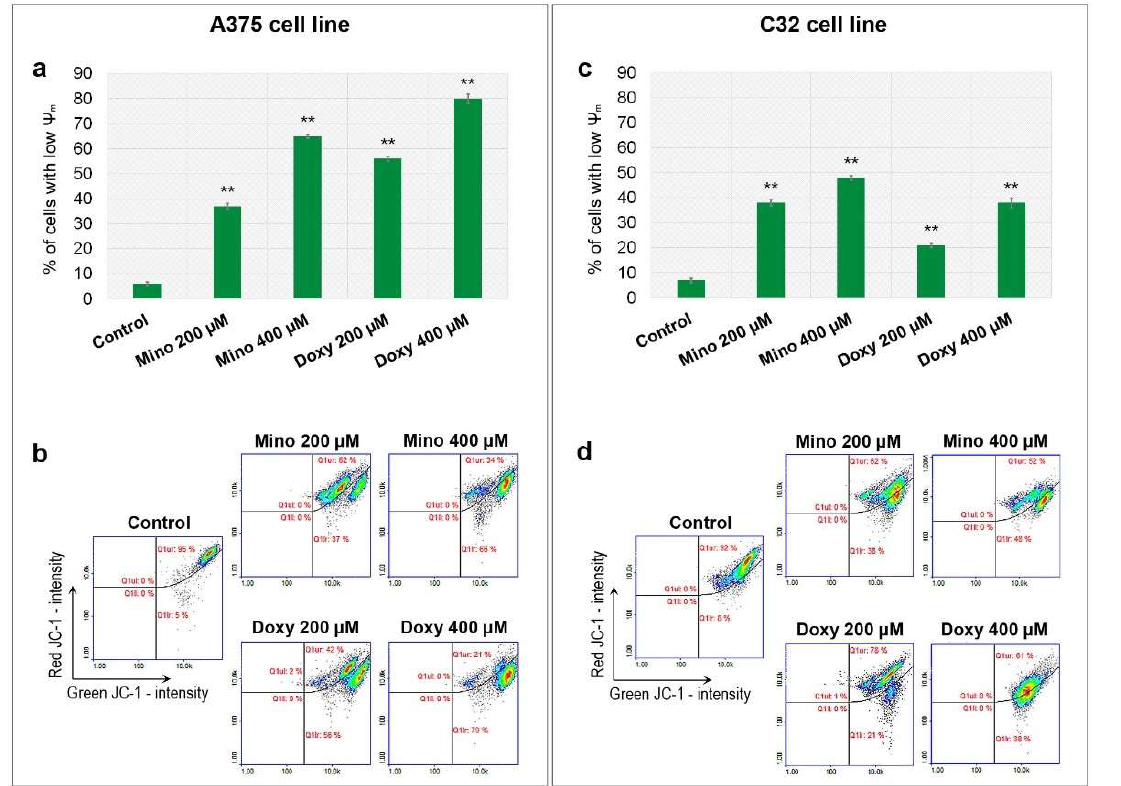
Figure 6. Analysis of mitochondrial membrane potential ( ψ m) after the treatment of melanoma cells with minocycline and doxycycline. Bar graphs present the results for A375 ( a ) and C32 ( c ) cell lines. Representative scatter plots ( b , d ) display tested populations of stained cells divided by a gate into the subpopulations of cells with polarized and depolarized mitochondria. ** p < 0.005 vs. control.